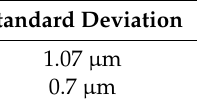
Figure 2. DLS graph of PVP-stabilized CdSe QDs, demonstrating homogeneity with PDI of 0.27 and average hydrodynamic diameter of 23 ± 7 nm. Table 2. Diameter analysis of